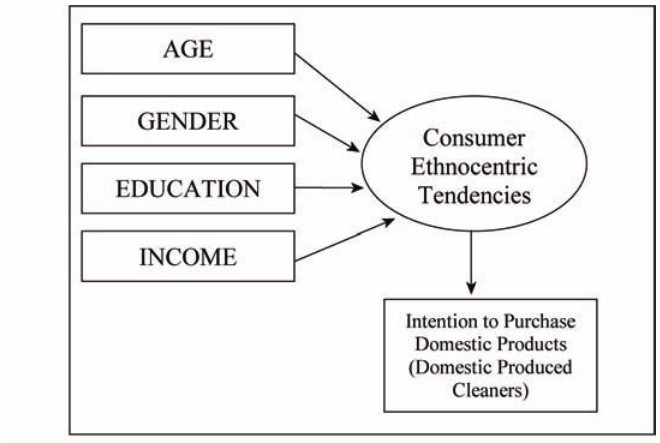
Fig. 1. The Conceptual Model of the